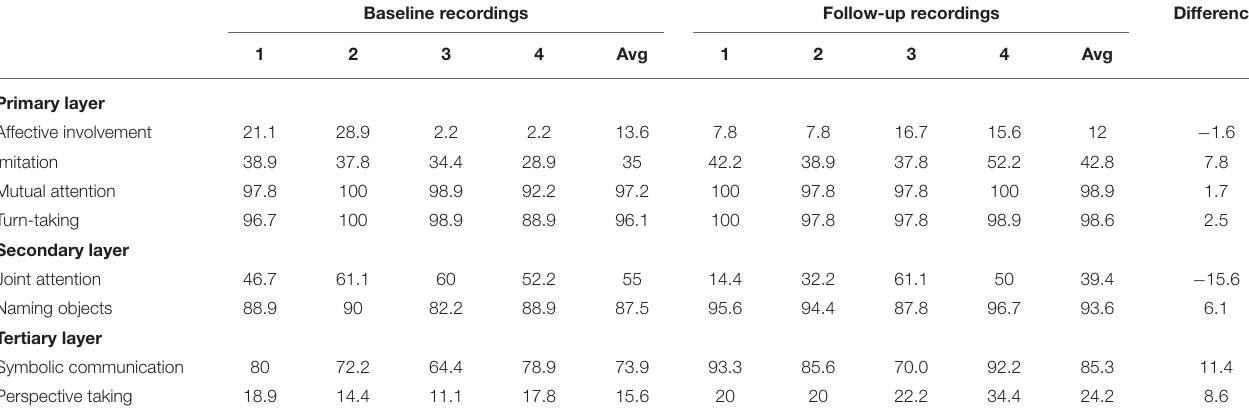
TABLE 10 | Percentage presence of LCM behaviors and difference in presence between baseline and follow-up recordings for dyad 8. Baseline recordings Follow-up